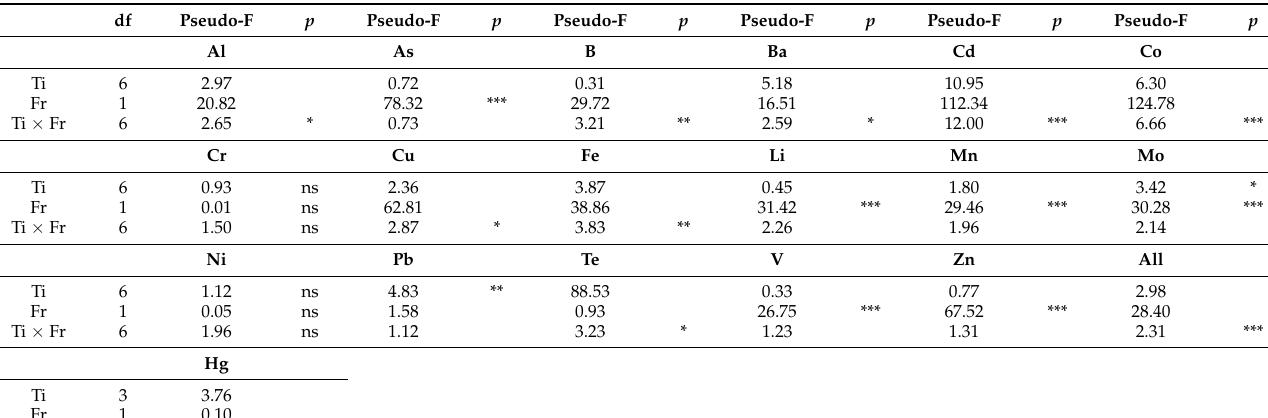
Table 2. Results of PERMANOVA testing for the differences between jellyfish fraction (umbrella and gonads) and sampling time on elemental composition and each elemental concentration analyzed (Al, As, B, Ba, Cd, Co, Cr, Cu, Fe, Li, Mn, Mo, Ni, Pb, Te, V, and Zn). Ti = time, Fr = fraction, df = degrees of freedom; MS = mean squares; Pseudo-F = F critic; * = p < 0.05; ** = p < 0.01; *** = p < 0.001; ns = not